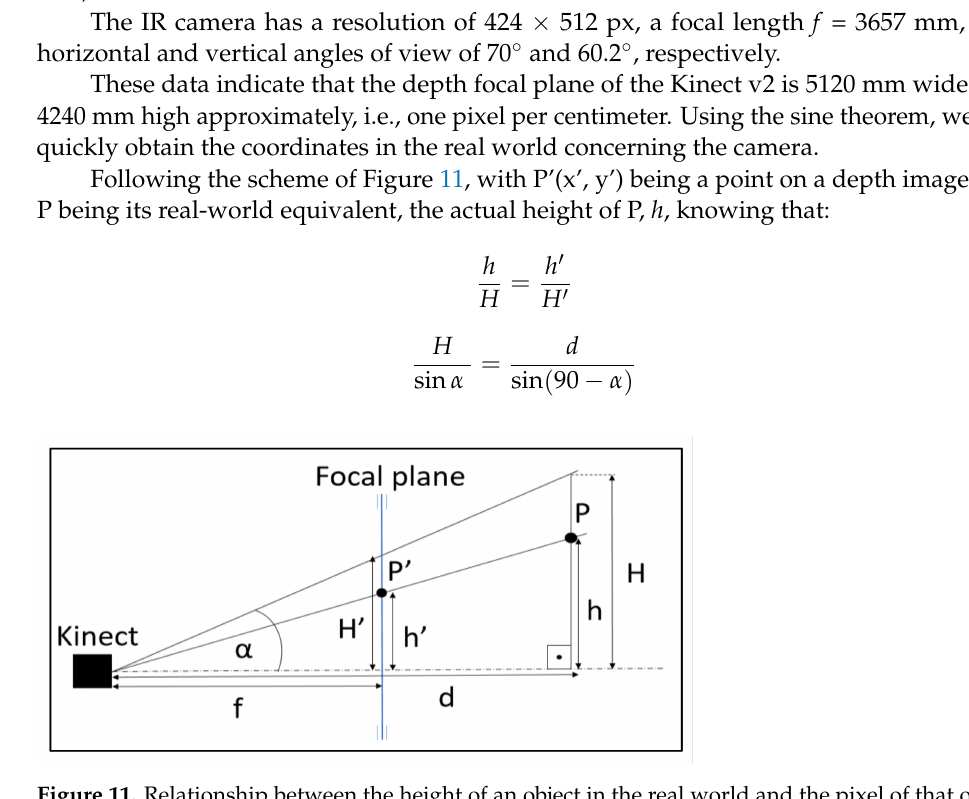
Figure 11. Relationship between the height of an object in the real world and the pixel of that object in a Kinect v2 depth